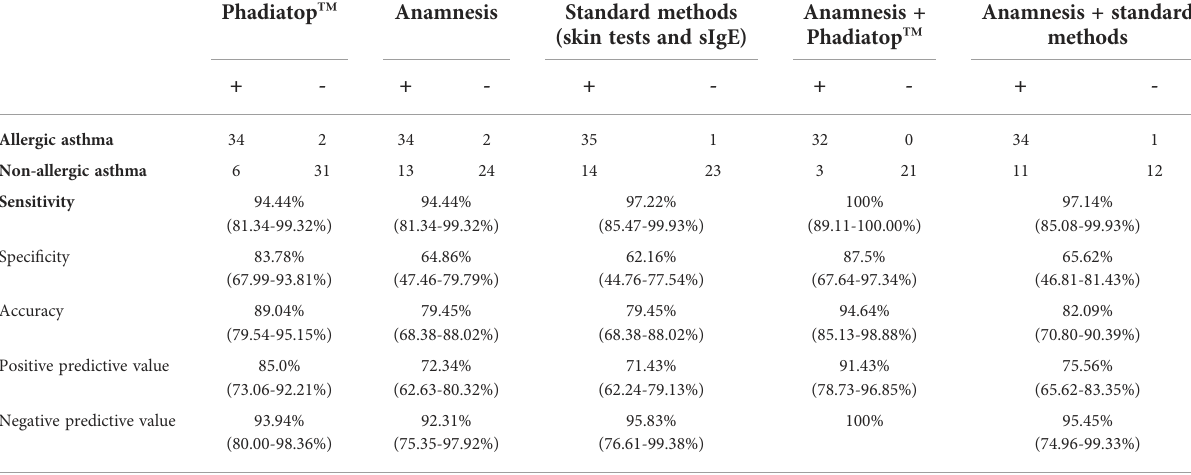
TABLE 4 Characteristics of diagnostic methods for de fi ning allergic asthma and their